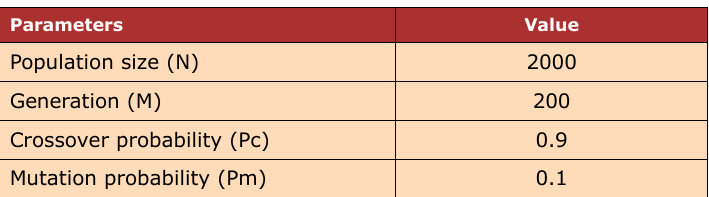
Table 3. Parameter of integrated GA